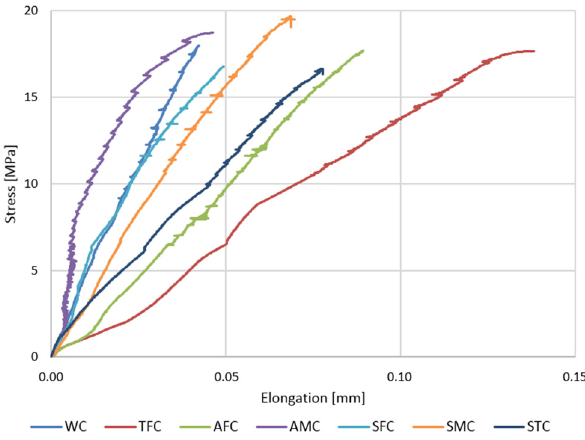
Figure 5: Example courses of